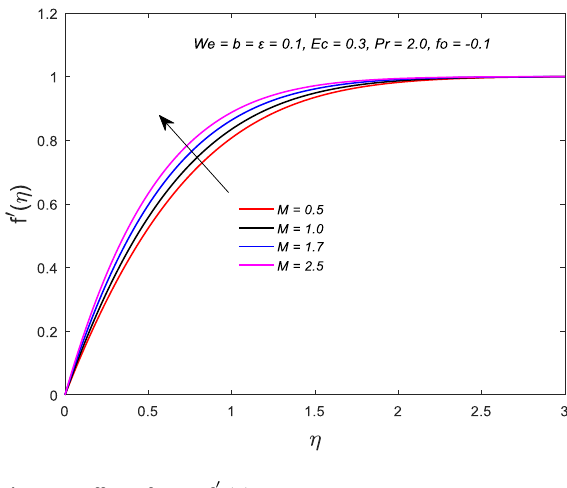
Figure 8: Effect of M on f (cid:48) ( η